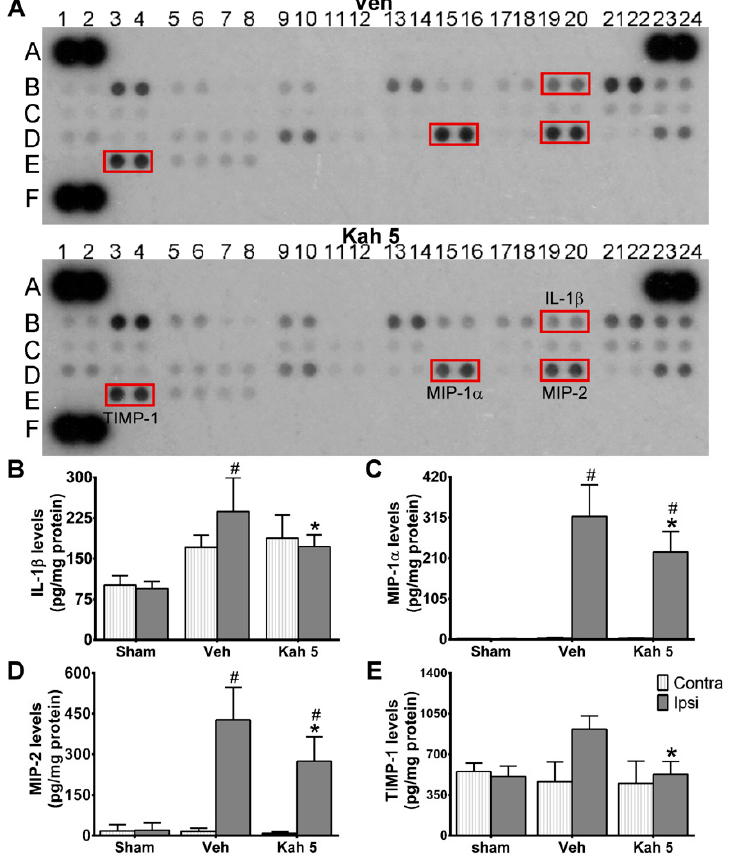
Figure 3. Kahweol treatment attenuated proinflammatory cytokines / chemokines secretion levels after TBI. ( A ) Representative chemiluminescence images of proteome profiler array from Veh- and Kah 5-treated TBI animals at 1-day post-injury. The red box indicates selected candidate proteins that were reduced by Kah 5 treatment. A1.2, A23.24, and F1.2 were the loading controls in the panels. n = 2 per group; each independent experiment includes three individual animals. Quantification analysis showed that increased levels of ( B ) IL-1 β , ( C ) MIP-1 α , ( D ) MIP-2, and ( E ) TIMP-1 in the vehicle group were markedly reduced in the Kah 5-treated day 1 TBI animals. n = 3 for sham group and n = 6 for Veh and Kah 5 groups. * p < 0.05 versus Veh group. # p < 0.05 versus Contra group. Data are the mean ± SD. Veh, vehicle; Kah 5, kahweol 5 mg / kg; Contra, contralateral; Ipsi, ipsilateral.